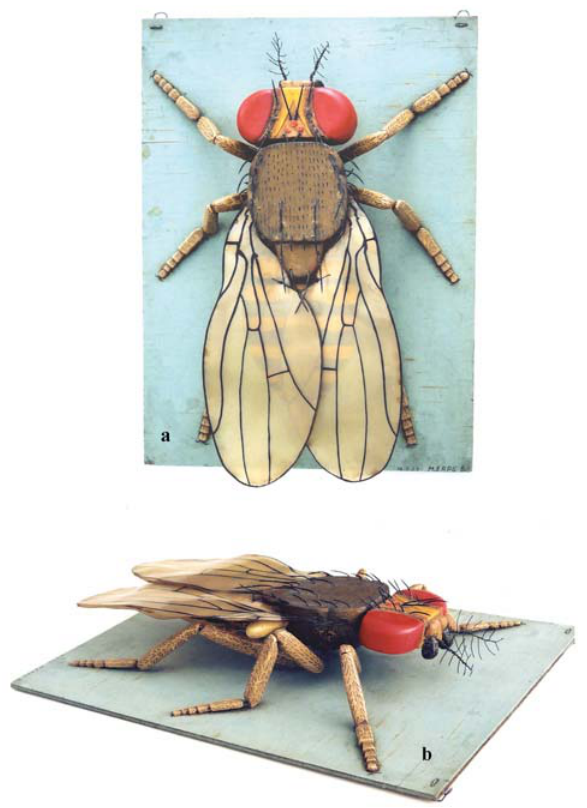
Figure 4 - Wood-carved female model of Drosophila melanogaster , con- structed by Marta Erps Breuer and housed in the archives of the Departamento de Genética e Biologia Evolutiva, Instituto de Biociências, Universidade de São Paulo , São Paulo, SP, Brazil: a. dorsal view (note the date - May 12 th , 1959 - and signature of Marta Erps Breuer in the lower right corner); b. lateroblique view (C. R. Vilela Phot.